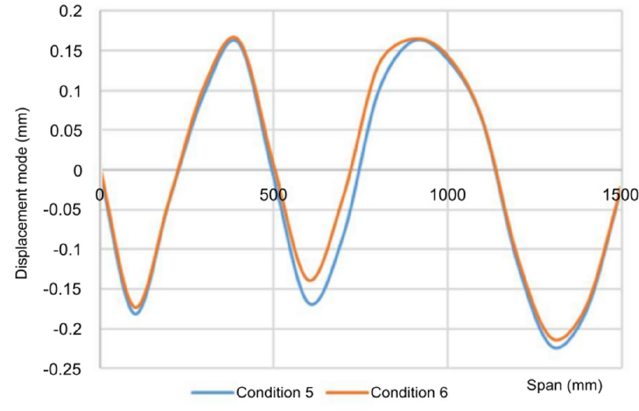
( e ) Comparison of the fifth-order vibration modes under Conditions 5 and 6. Figure 12. Comparison of the first five orders of vibration modes under Conditions 5 and 6. The displacement modes under Condition 5 (stiffened and nondamaged) and Condi- tion 7 (stiffened and damaged at the 1/4 position) were compared, as shown in Figure 13.